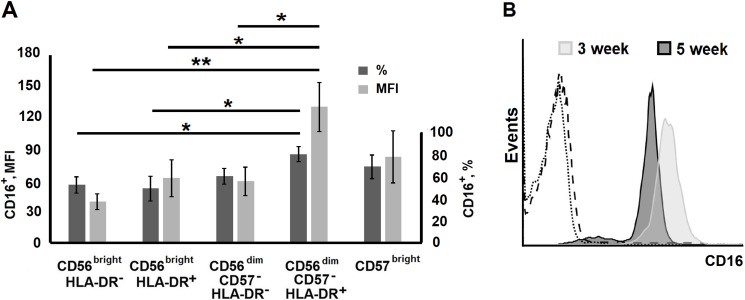
Surface expression of CD16 in NK cell clones.(A) Expression levels of CD16 in clones derived from different NK cell subsets analyzed at week 5 of cultivation. Proportions of CD16+ cells and MFI of CD16+ cells (mean ± SE) of n experiments are presented: n = 12 for CD56brightHLA-DR–, n = 10 for CD56brightHLA-DR+, n = 13 for CD56dimCD57– HLA-DR–, n = 13 for CD56dimCD57–HLA-DR+, and n = 8 for CD56dimCD57brigh. (B) CD16 surface expression in a NK cell clone from CD56dimHLA-DR−subset measured at weeks 3 and 5. The dotted line indicates autofluorescence, dashed line is the isotype control.